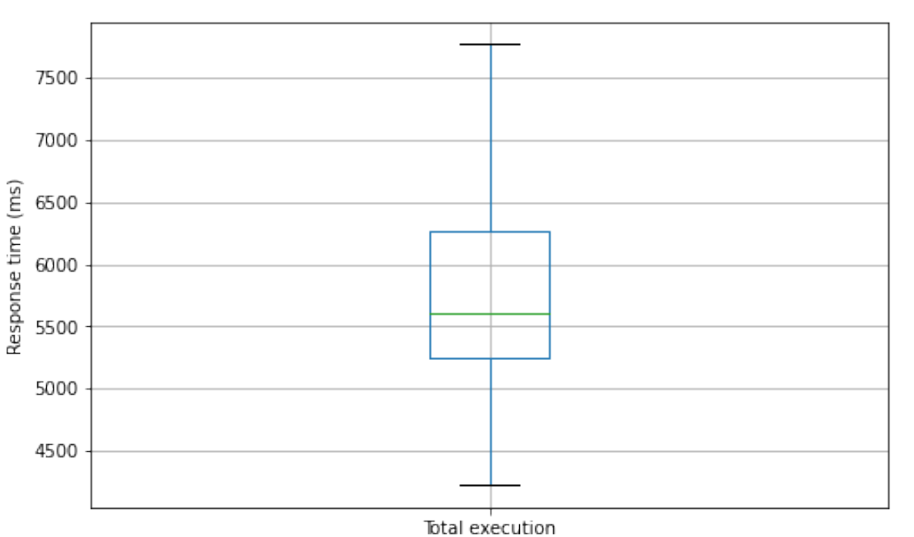
Figure 8. Total execution